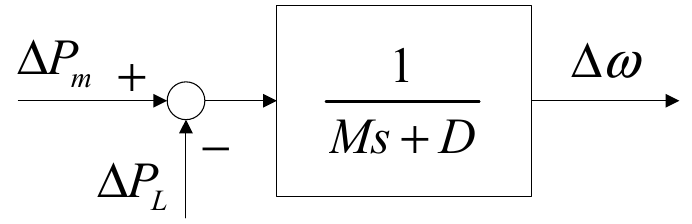
Figure 2. Model structure of frequency characteristic.